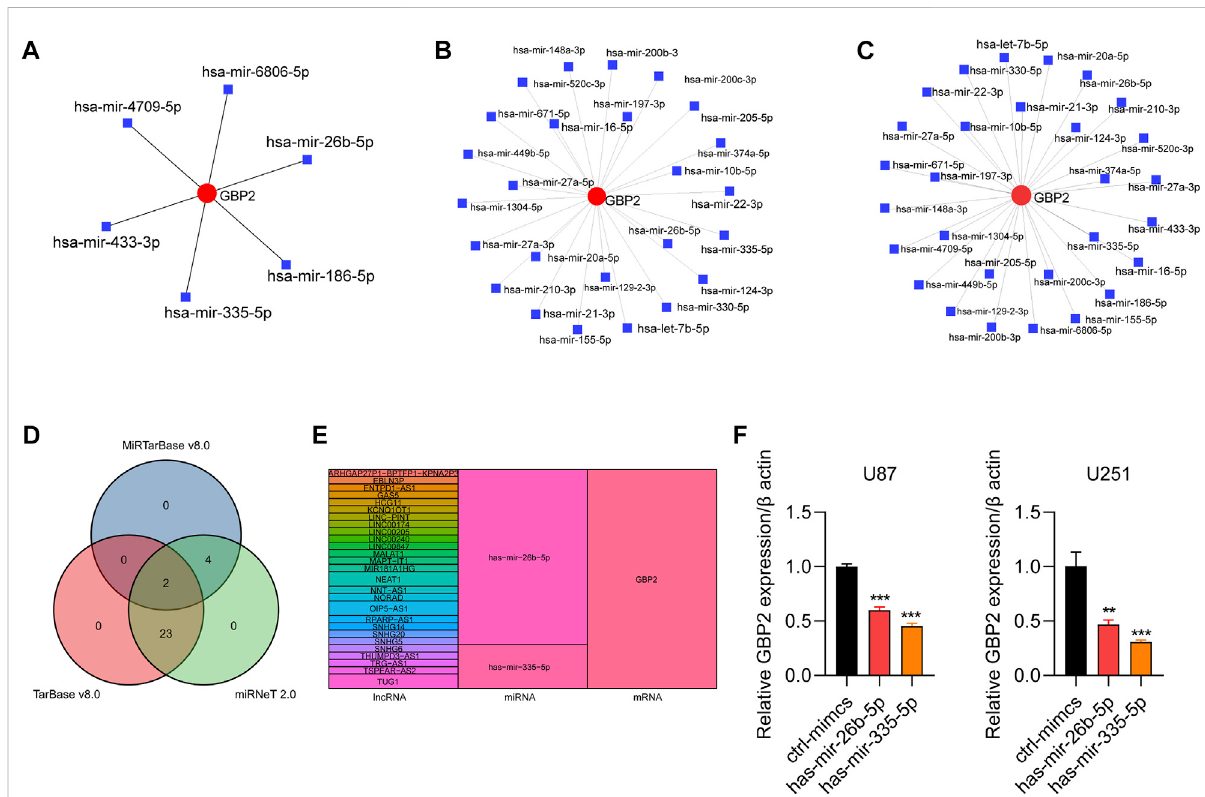
FIGURE 7 The role of noncoding RNAs in regulating GBP2. (A – C) GBP2-related miRNAs in miRTarbase database (A) , Tarbase database (B) and miRNet database (C) . (D) Venn diagram showing overlapping miRNAs that are predicted to target GBP2 in three databases, including miRTarBase, TarBase, miRNet. (E) Sankey plot showing regulatory network among lncRNAs, miRNAs, and mRNAs. The colored bands visualize the relationship between regulatorsandtheirpredictedtargets. (F) qRT-PCRanalysisofGBP2inU87andU251cellstransfectedwithmimicsNC,mimicsmiR-26b-5pand mimics miR-335-5p. The expression of GBP2 was adjusted to the expression of β -actin. ** p < 0.01, *** p <